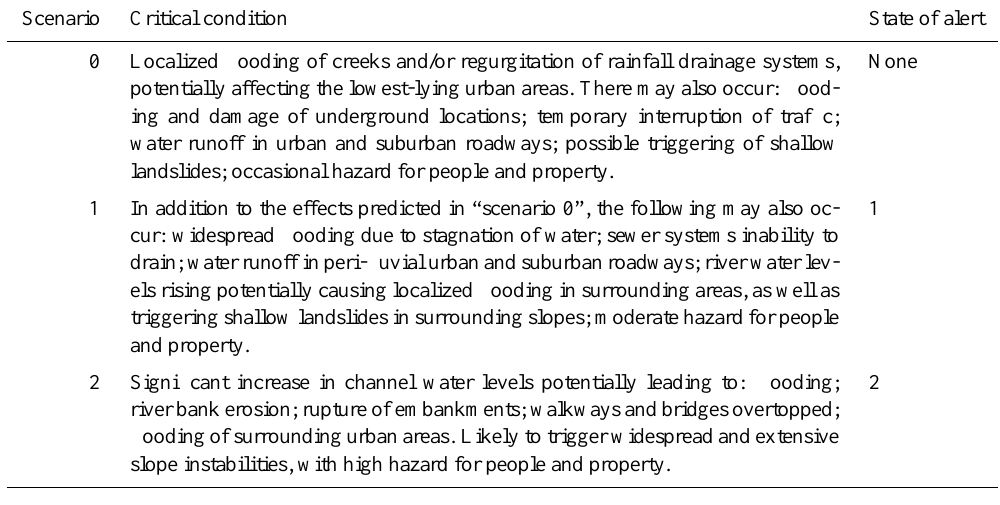
Table 1. Scenarios and alert states defined on the basis of a range of potential critical conditions (from Regione Liguria, 2008).